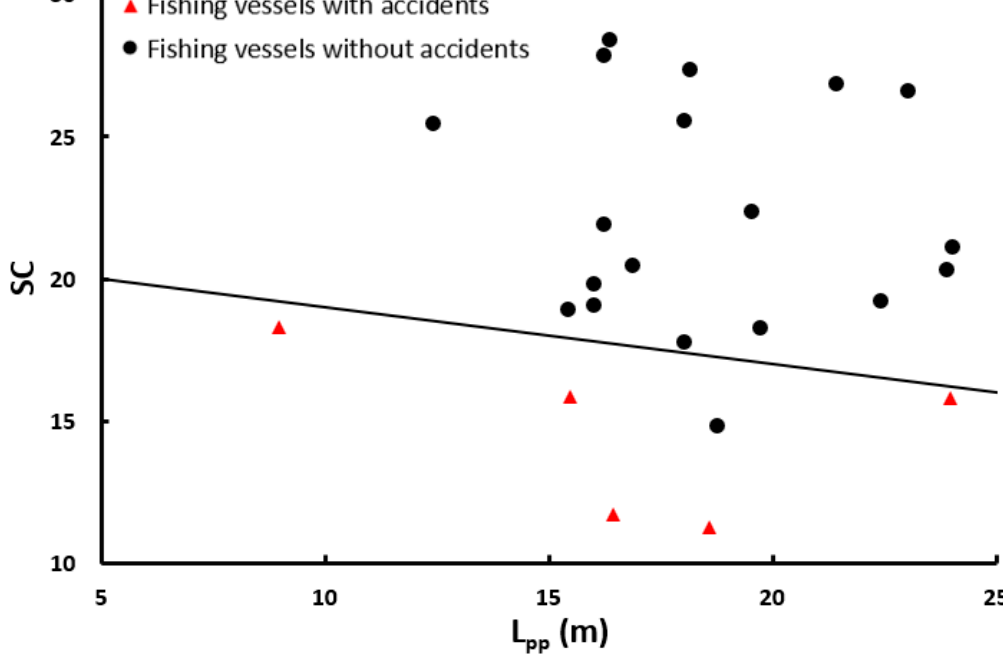
Figure 8. The effect of vessel length ( L pp ) over the sum of the initial stability coefficient ( C 1 ) and the dynamic stability coefficient ( C 1 + C 2 = SC ).